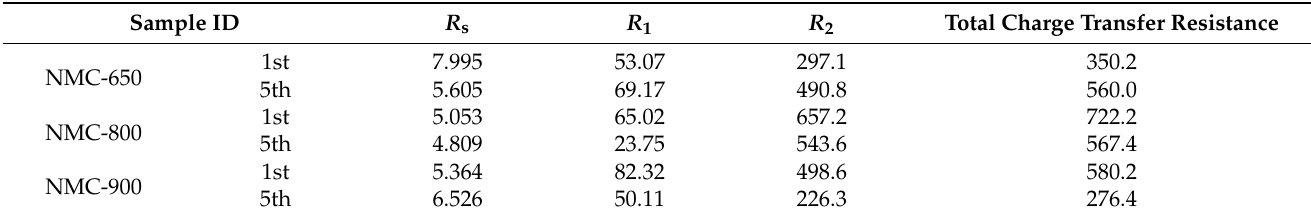
Table 2. Resistance parameters obtained from EIS